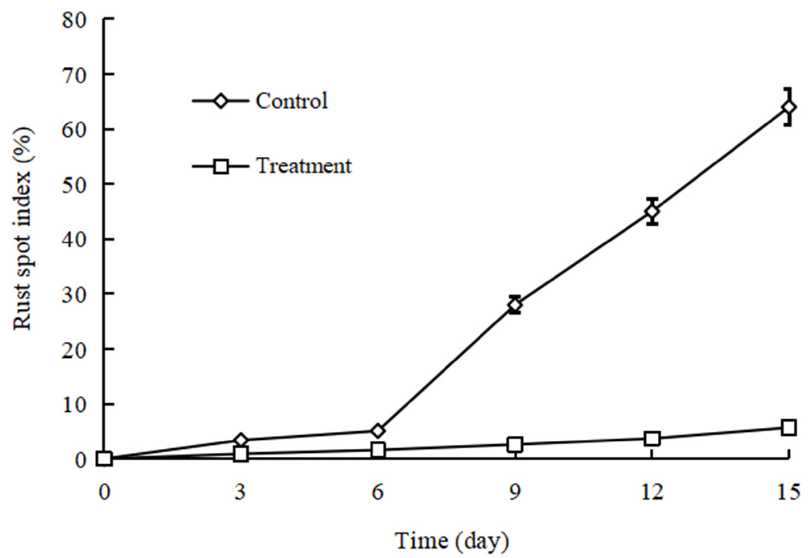
Figure 3. Effect of pullulan-based coatings on the rust spot index of cowpeas during refrigerated storage. Bars represent the standard deviation ( n = 6).